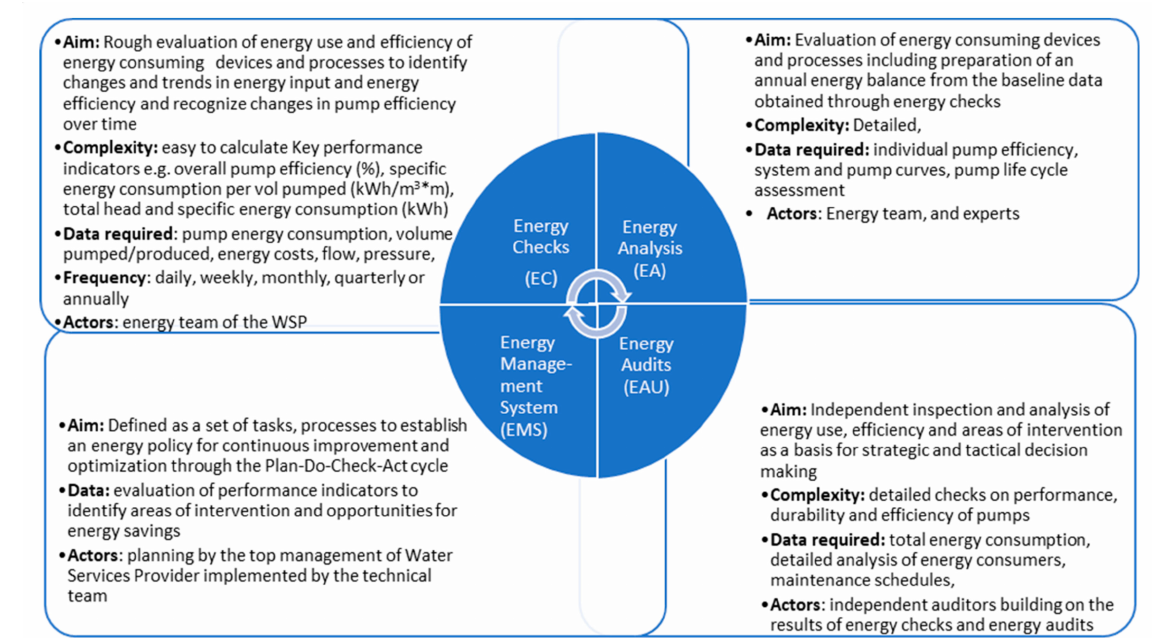
Figure 4. Energy management strategy processes for water supply adapted from